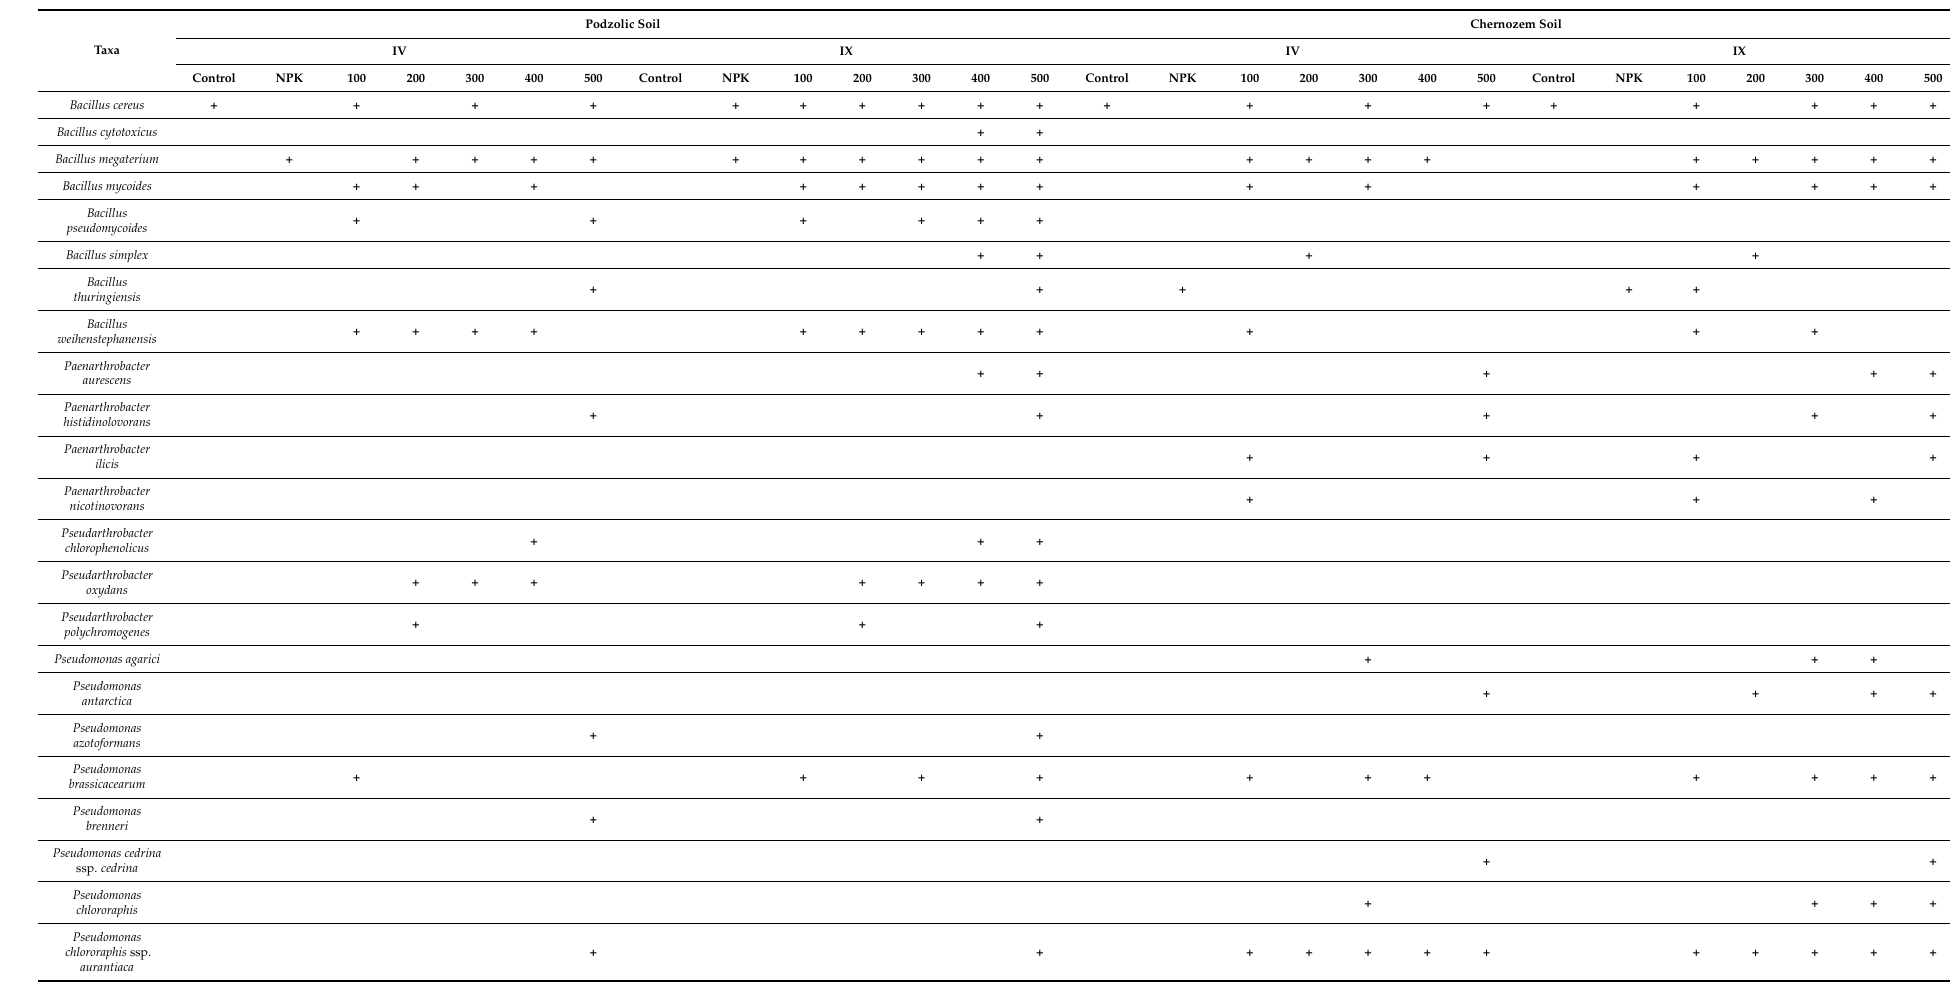
Table 4. List of bacterial species identified using MALDI-TOF MS in the podzolic and chernozem soils under winter rape cultivation in April and September 2021. Control (without fertilization), NPK K 2 O in mineral fertilizers, 100–100 kg K 2 O ha − 1 in ash, 200–200 kg K 2 O ha − 1 in ash, 300–300 kg K 2 O ha − 1 in